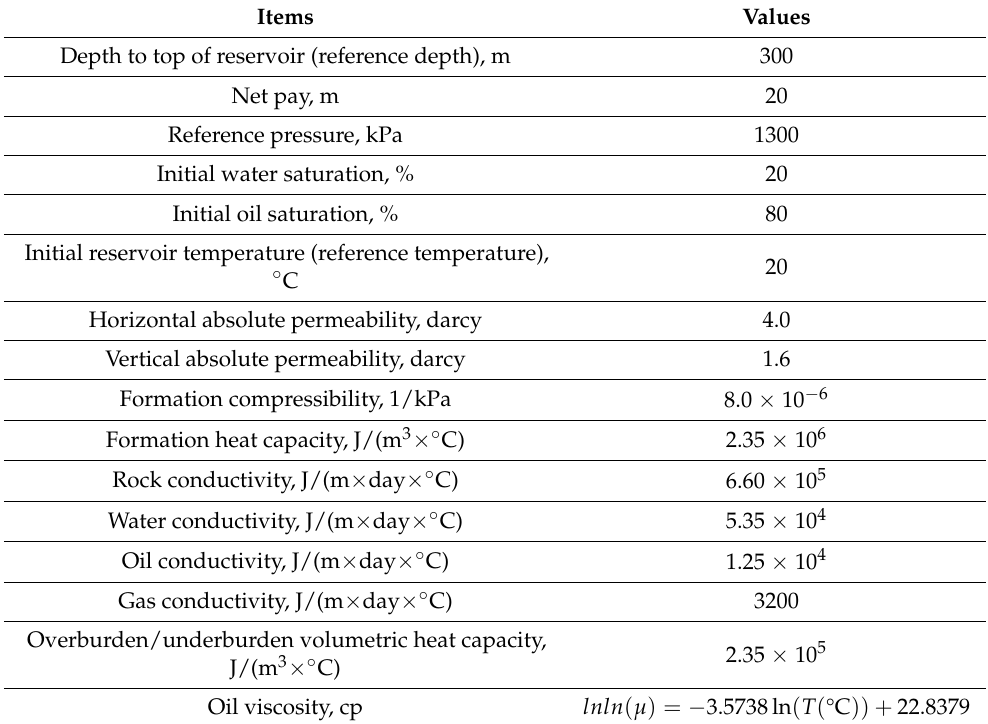
Table 1. Key reservoir model parameters.